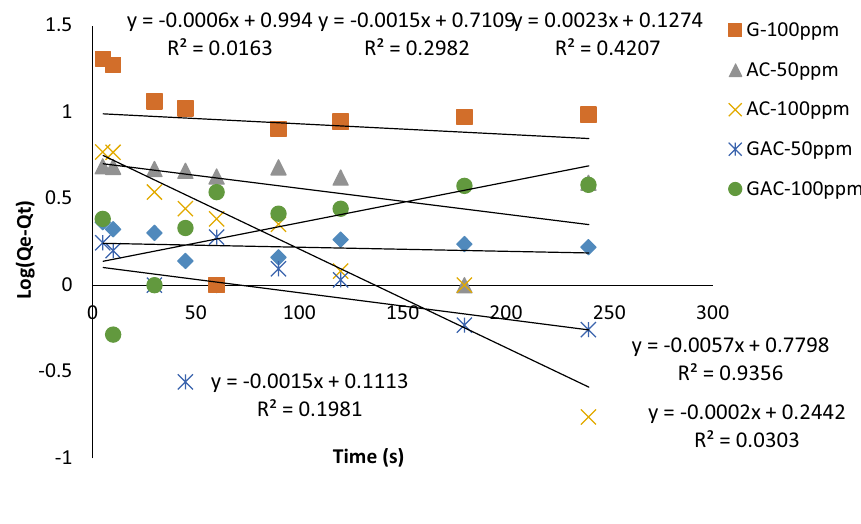
Fig. 13 Linearized plot of pseudo-first-order model plot of Cr(VI) adsorption onto G, AC and GAC